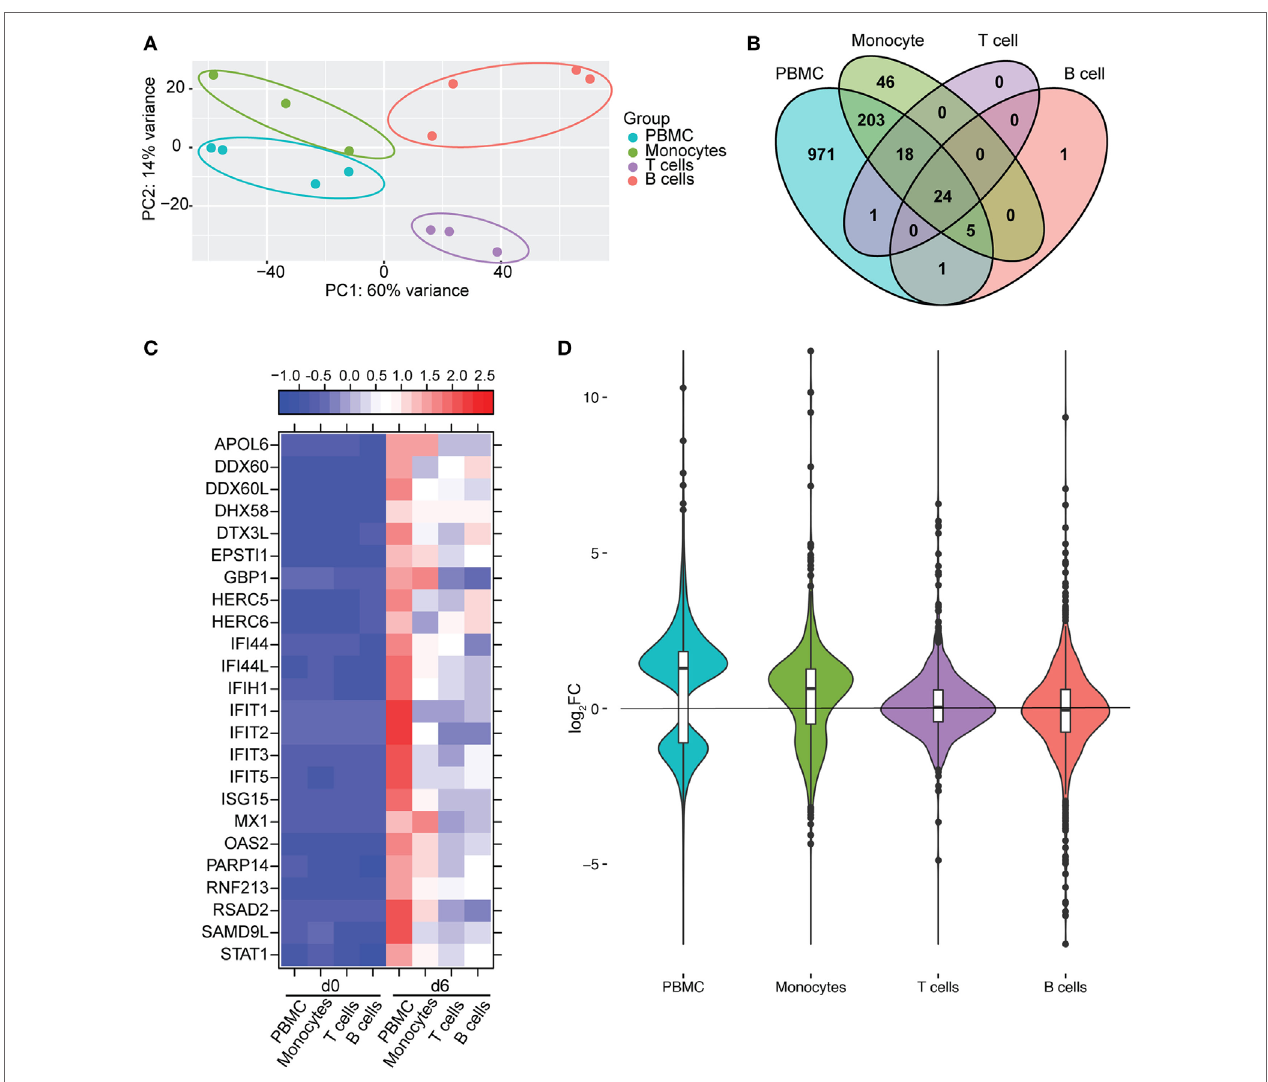
FigUre 6 | Monocytes contribute a significant proportion of transcriptional changes detected in peripheral blood mononuclear cells (PBMC). (a) Principal component analysis of normalized transcript numbers 6 DPI in PBMC, monocytes, T-cells, and B-cells. (B) 4 way Venn diagram showing overlap between differentially expressed genes (DEGs) detected 6 DPI in PBMC, monocyte, T-cells, and B-cells. (c) Heatmap representing gene expression (shown as absolute normalized RPKM values) of the 24 DEGs detected in PBMC as well as purified monocytes, T- and B-cells 6 DPI; range of colors is based on scaled and centered RPKM values of the entire set of genes (red represents increased expression while blue represents decreased expression); each column represents the median RPKM values on each day for each subset. (D) Violin plot of the log 2 FC of 971 DEGs that were exclusively detected in PBMC within each cell